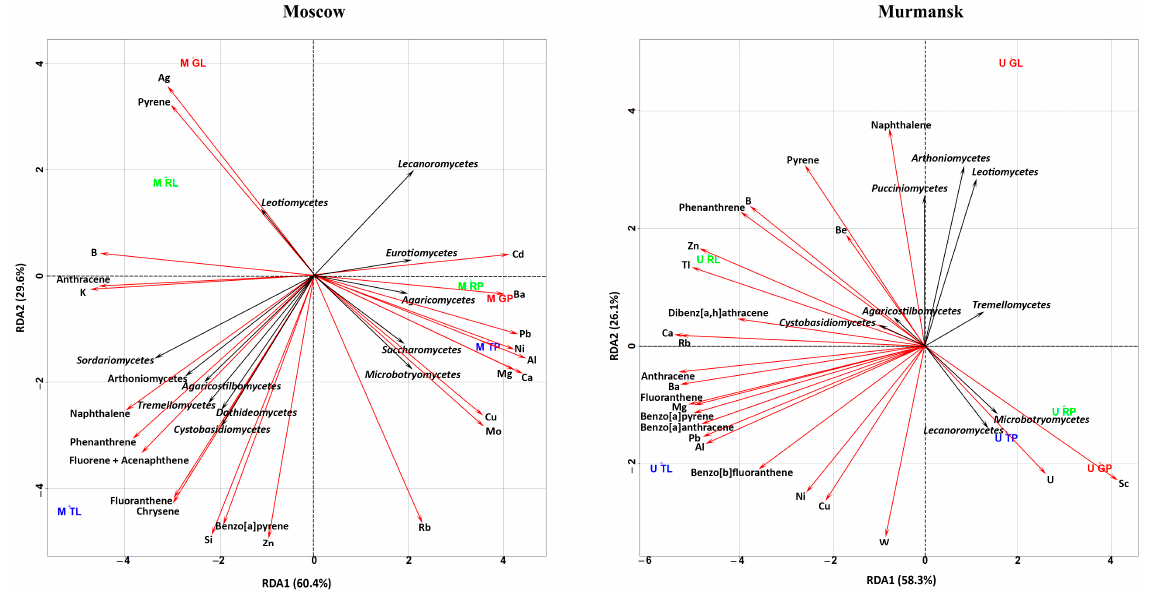
Figure 5. RDA ordination triplot showing the correlations of chemical pollutants (red arrows) and fungal classes (black arrows) of the leaf dust and road dust from Moscow and Murmansk. The first letter in the abbreviation refers to the city: M–Moscow, U–Murmansk; the second letter refers to the functional zone: T–traffic, R–residential, G–recreational; and the last letter refers to the biotope: L–leaf, Ppaved surface. The figures show only those classes of fungi, metals, and PAHs that had a correlation with each